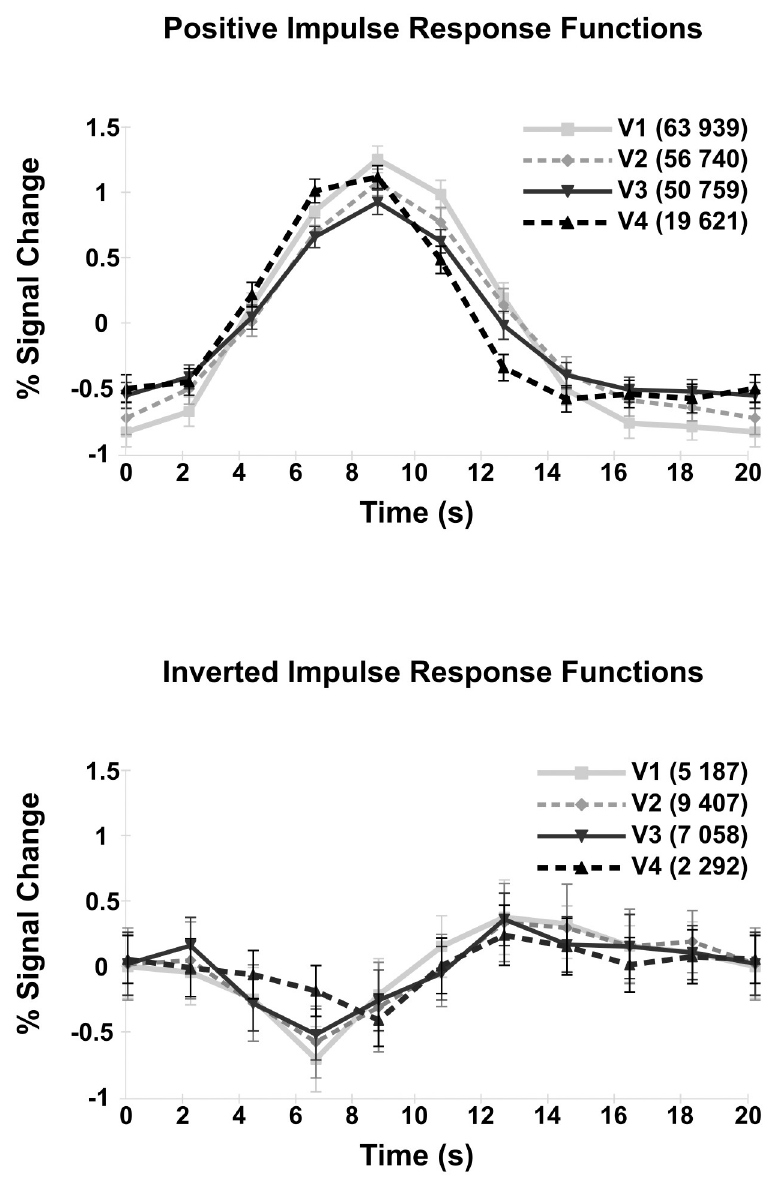
Fig 10. Positive and inverted IRFs for V1-hV4, averaged across subjects and hemispheres. Voxel counts are displayed in brackets. Error bars represent +-1 SEM.